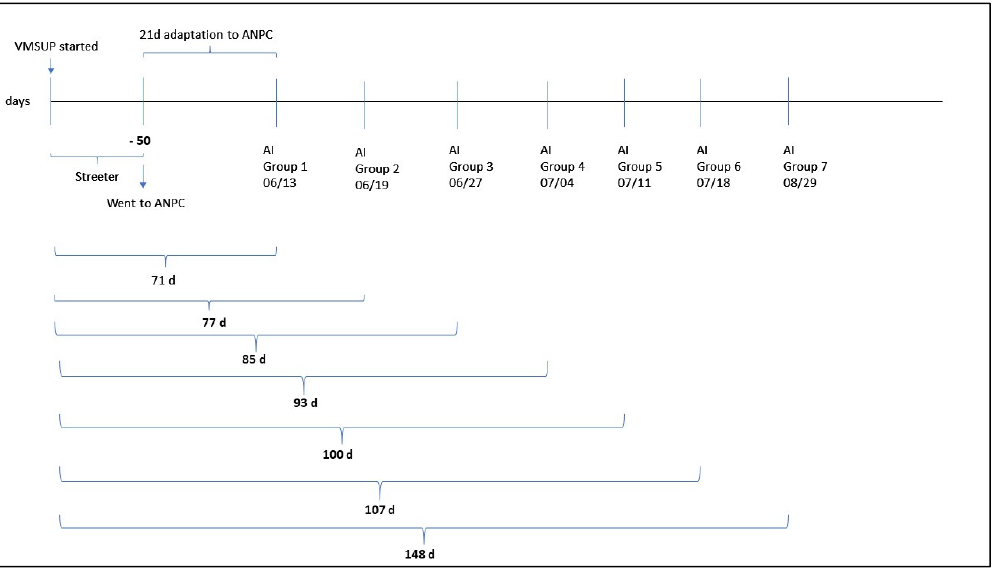
Figure 1. Feeding timeline for vitamin and mineral supplementation [VMSUP; supplemented (VTM) vs. unsupplemented (NoVTM)]. AI: Artificial Insemination; ANPC: Animal Nutrition and Physiology Center (Fargo, ND, USA).